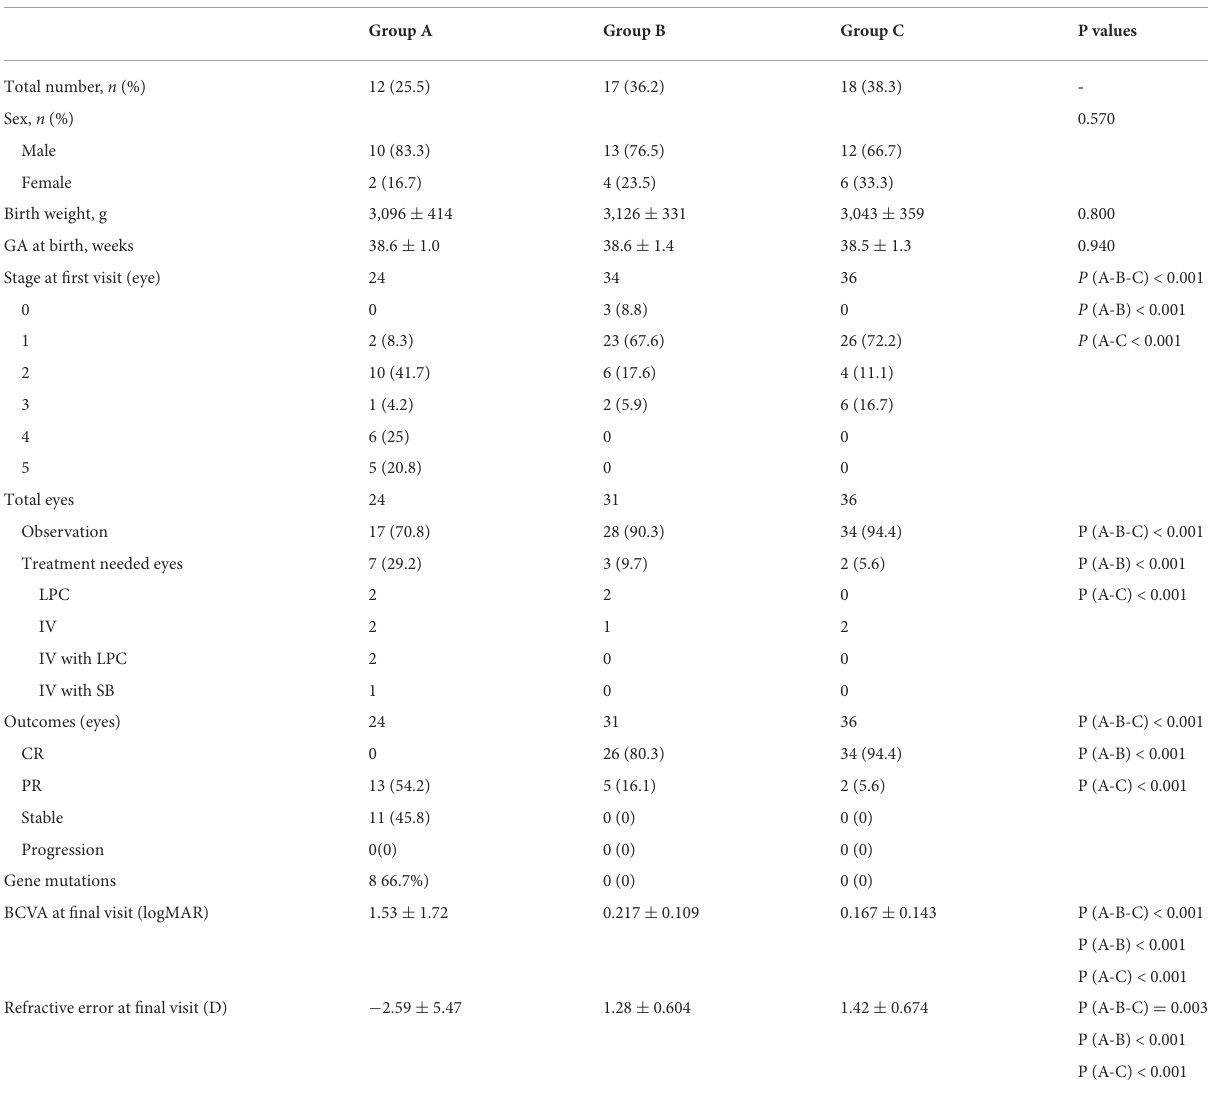
TABLE 4 Sub-grouping of ROPLR neonates and the analysis of the risk factors and outcomes. Group A Group B Group